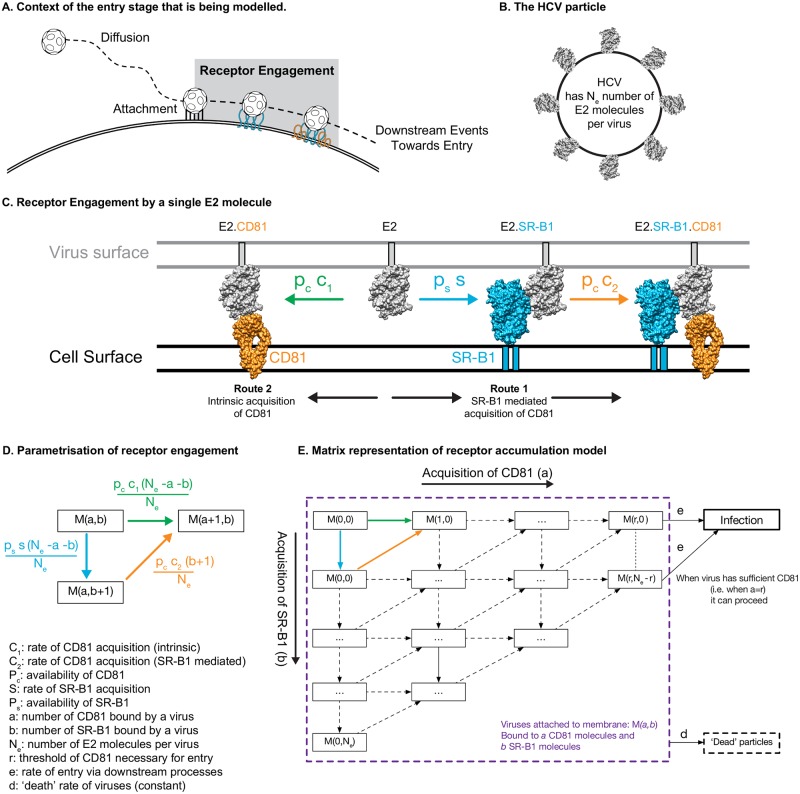
Building a mechanistic model of HCV entry.A. Following attachment HCV particles must engage and accumulate CD81 to proceed to entry. B. To model this process we must consider a HCV particle that has an unknown (Ne) number of E2 molecules. C. We modelled E2 receptor engagement to occur via two routes: 1. prior engagement of SR-B1 enhances E2 interaction with CD81 2. acquisition of CD81 via intrinsic binding, with no prior involvement of other receptors. The molecular models are drawn to scale and are based on published crystal structures (E2 PDB:6MEJ;CD81 PDB:5TCX; SR-B1 homology model based on PDB:4F7B [56,63,64]) D. A parameterised mathematical framework of receptor engagement. Each box represents the receptor engagement state of cell-attached viruses (M), where the values in parentheses denote receptor number. For example, M(0,0) represents viruses that have attached but have not yet engaged either receptor, M(1,0) represents viruses that have acquired one molecule of CD81 and M(0,1) are viruses with one molecule of SR-B1. The steps in this process have been parameterised to include the availability of receptor (determined by experimental data) and the rate of engagement (estimated by modelling). They have also been scaled relative to the number of available E2 molecules (Ne). For clarity, parameterised steps are also shown in C. E. A matrix model of HCV receptor accumulation. To achieve productive infection (I) virus particles must move laterally, acquiring CD81, this is achieved via the routes defined in D. The dimensions of this matrix represent the stoichiometry of receptor engagement (i.e. how many molecules of CD81 are required for entry), we investigated this through the modelling process. There are two additional parameters in the model, e integrates all downstream events in the virus life cycle leading to productive infection, whereas d is the rate of spontaneous virus inactivation, or ‘death’.